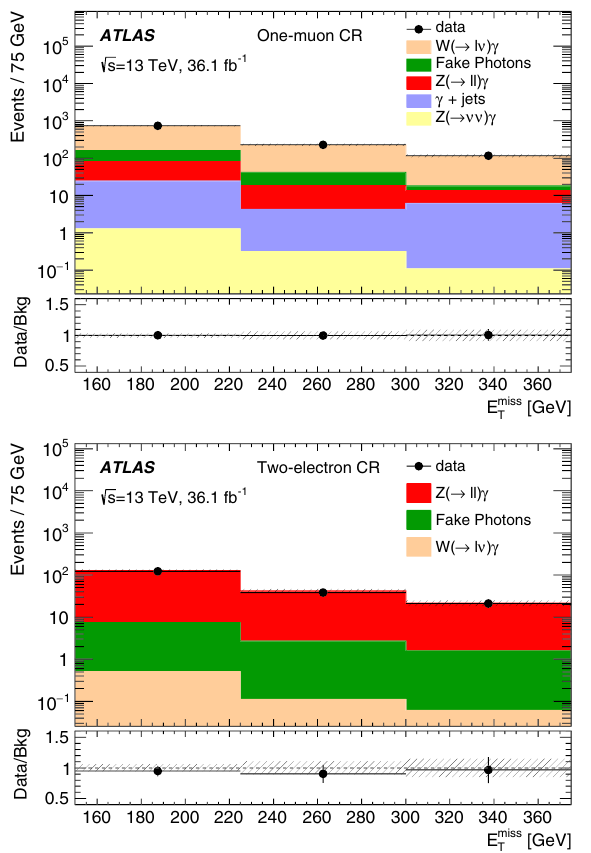
Table 4 Observed event yields in 36.1 fb − 1 of data compared to expected yields from SM backgrounds in the signal region SRI1 and in its four control regions (CRs), as predicted from the simultaneous fit to CRs of SRI1 (see text). The MC yields before the fit are also shown. The uncertainty includes both the statistical and systematic uncertain- ties described in Sect. 8. The uncertainty on the pre-fit background is the pre-fit uncertainty, while the uncertainties on the fitted background